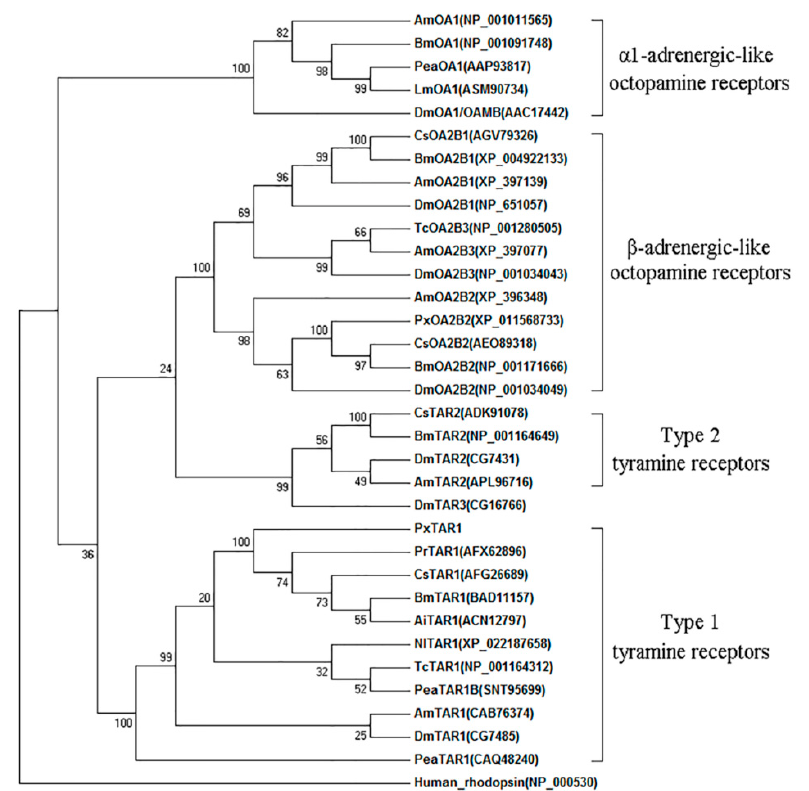
Figure 2. Phylogenetic tree analysis of representative members of the different TARs and OARs. Alignment was performed using amino acid sequences from TM1 to TM7 and the numbers at the nodes of the branches represent the level of bootstrap support for each branch. GenBank accession numbers of each receptor sequences are listed in the tree. Abbreviations of species in alphabetical order are: Ai, Amphibalanus improvises ; Am, Apis melifera ; Bm, Bombys mori ; Cs, C. suppressalis ; Dm, D. melanogaster ; Dp, Danaus plexippus ; Lm, L. migratoria ; Nl, Nilaparvata lugens ; Pea, P. americana ; Pr, P. rapae ; Px, P, xylostella ; and Tc, Tribolium castaneum.